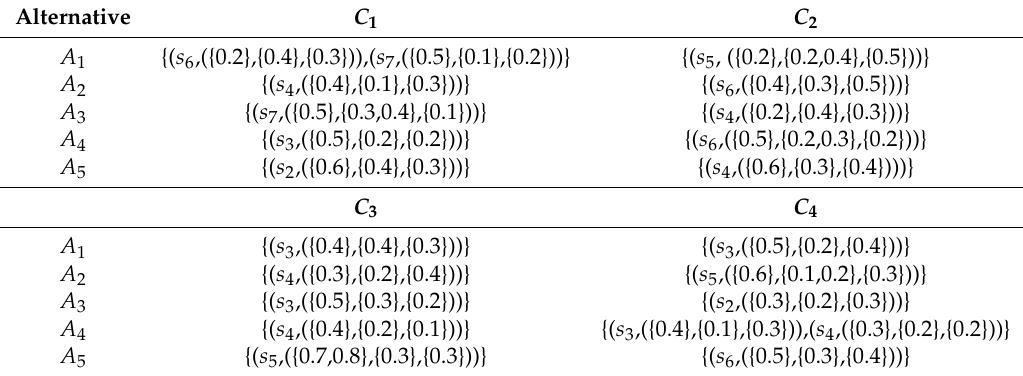
Table 2. Decision matrix D 2